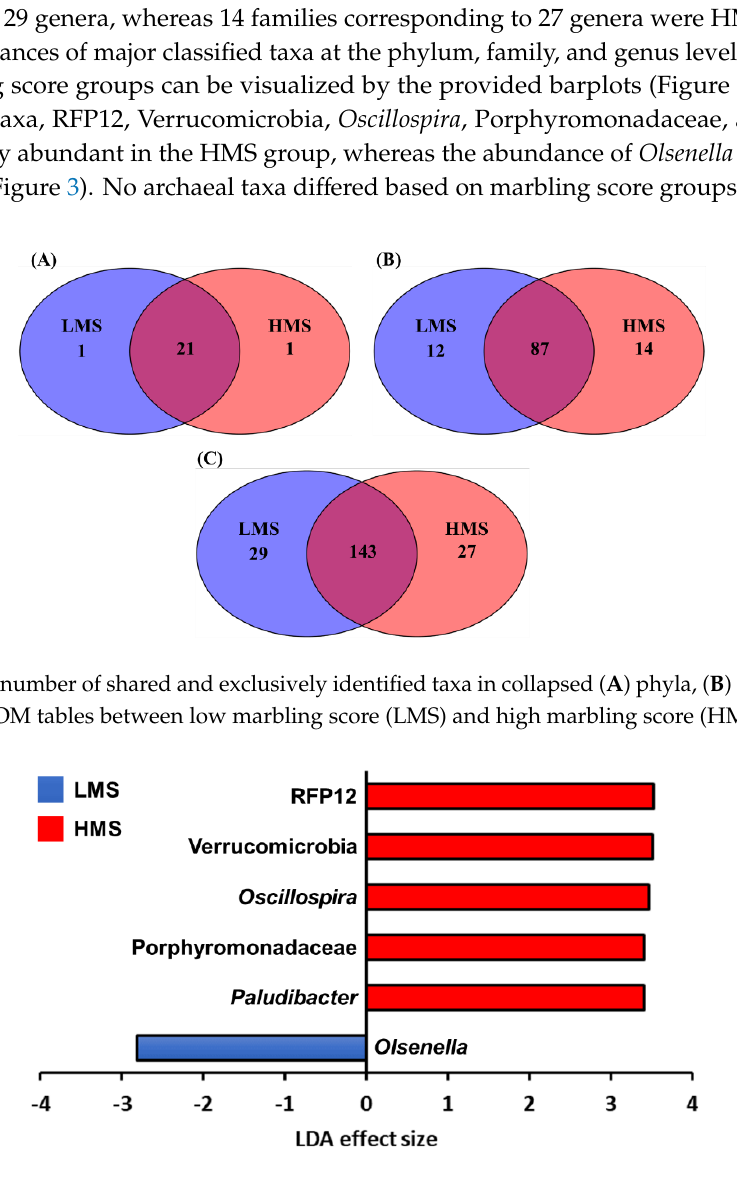
Figure 1. Principal coordinates analysis based on both unweighted ( A ) and weighted ( B ) UniFrac distances of prokaryotic populations in the rumen of Korean beef cattle. PERMANOVA was computed for non-parametric statistical tests between low marbling score (LMS) and high marbling score (HMS) groups.